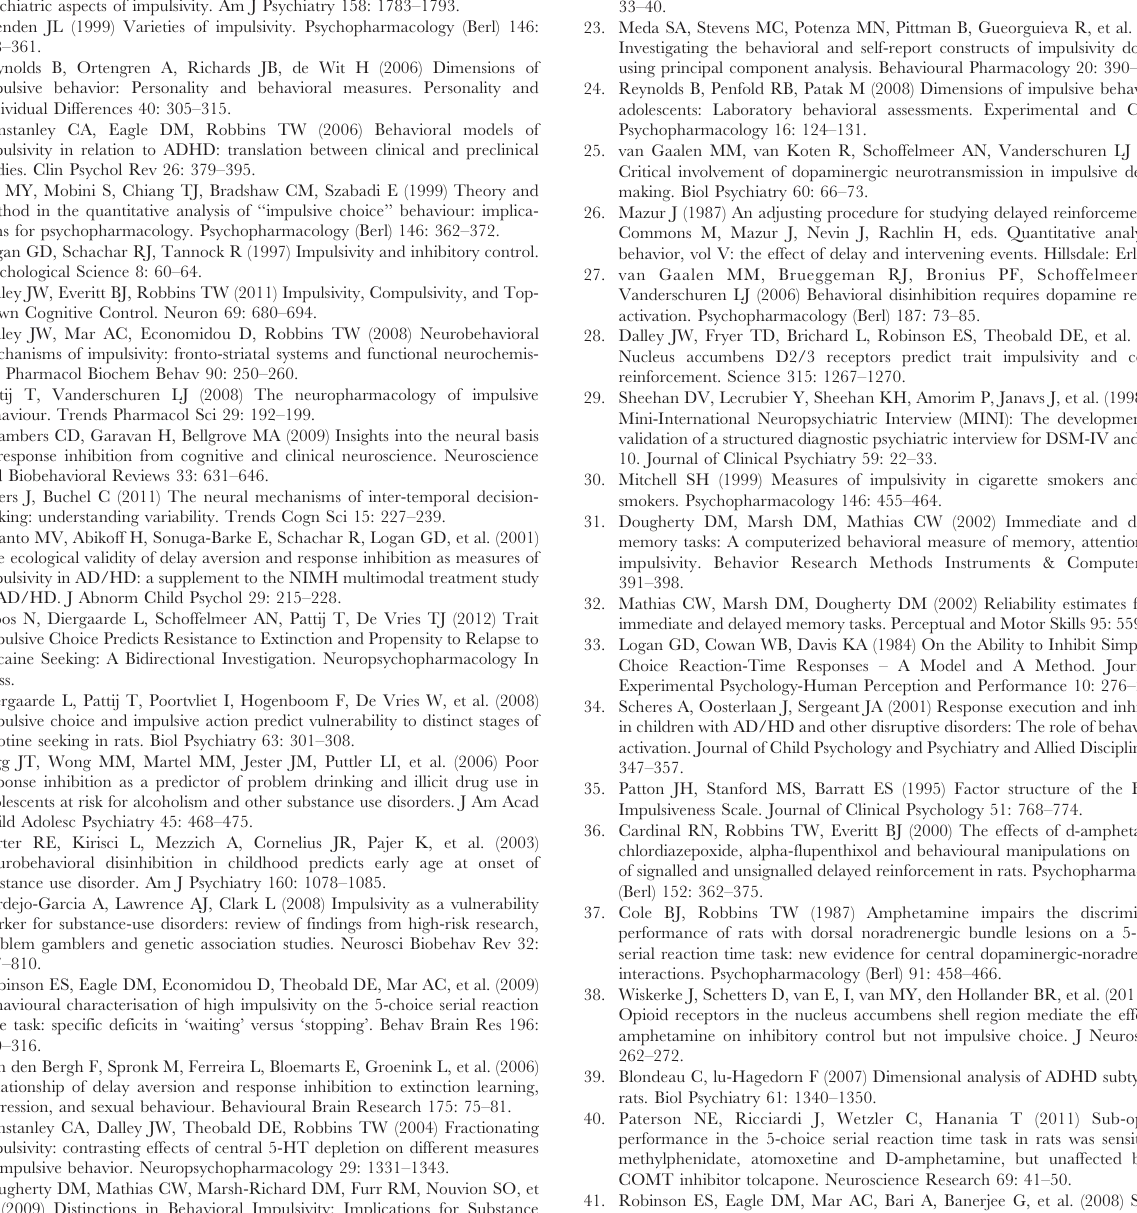
differences between males and females on any of the measures, indicating that gender had no influence on the correlation and factor